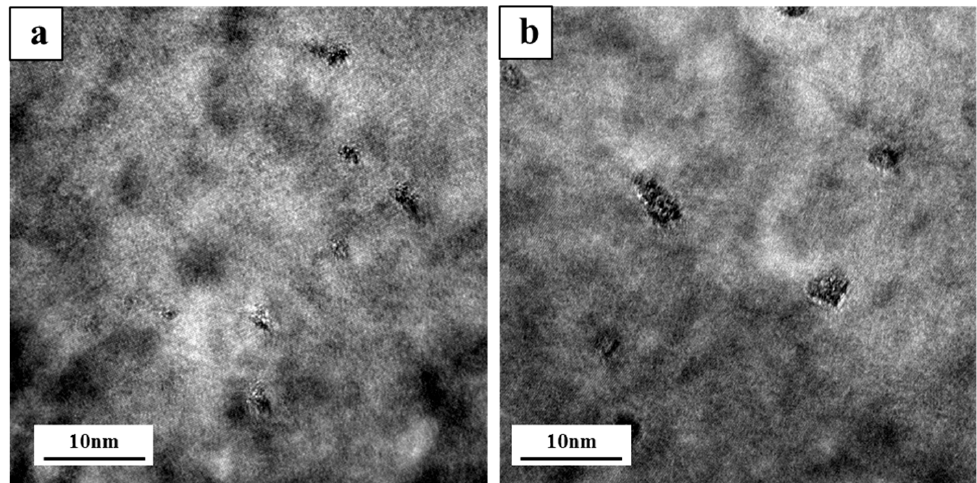
Figure 5. Precipitates after two-stage solution treatment and aging treatment (12 h), ( a ) Cd-containing alloy and ( b ) Cd-free alloy.